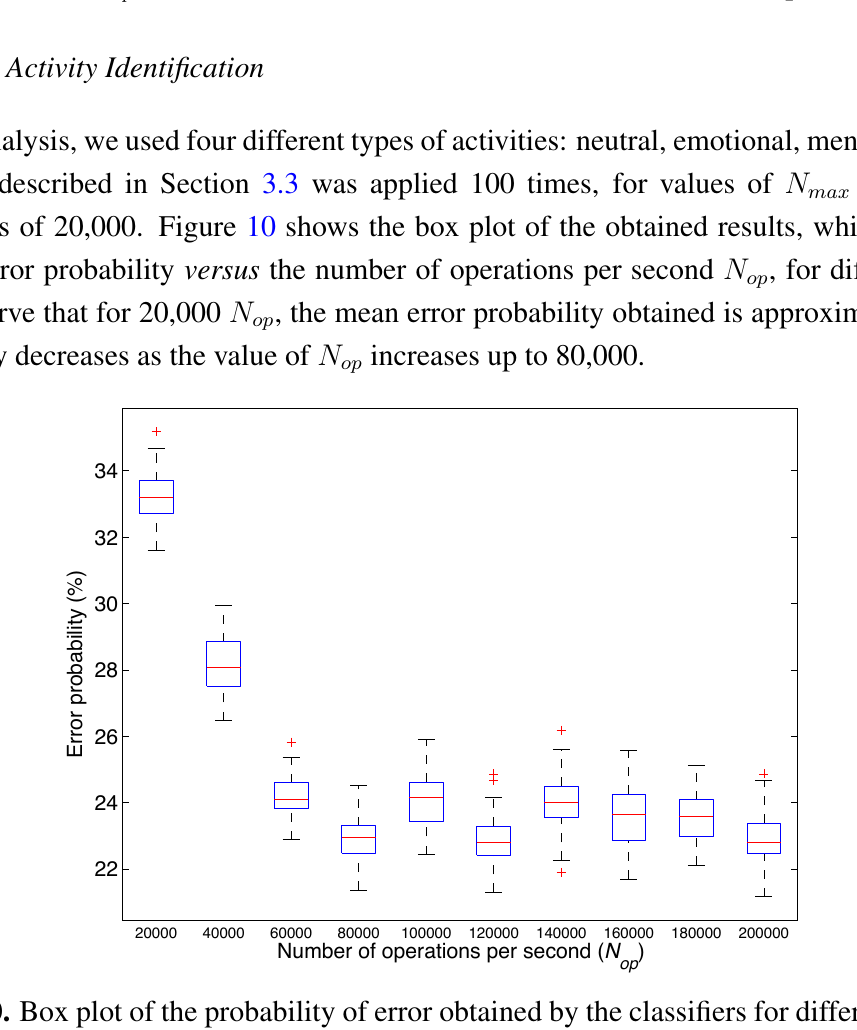
) particularized for Analysis 1: type op